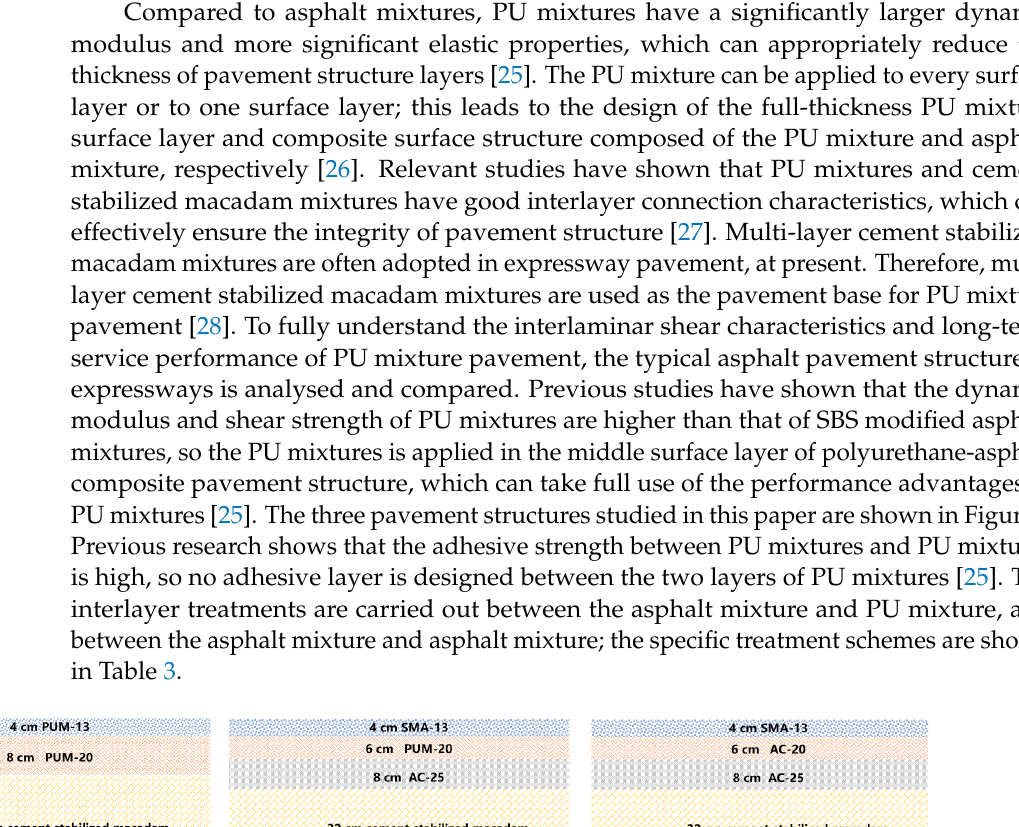
Figure 2. Mineral aggregate gradation design results.